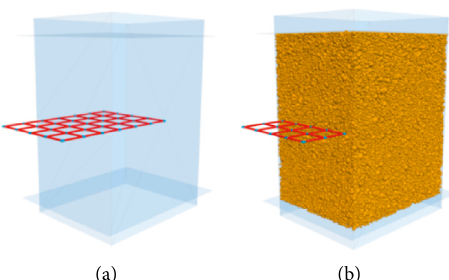
Figure 4: PFC3D geogrid pull-out test model. (a) Pull-out box and geogrid model, and (b) pull-out test model.